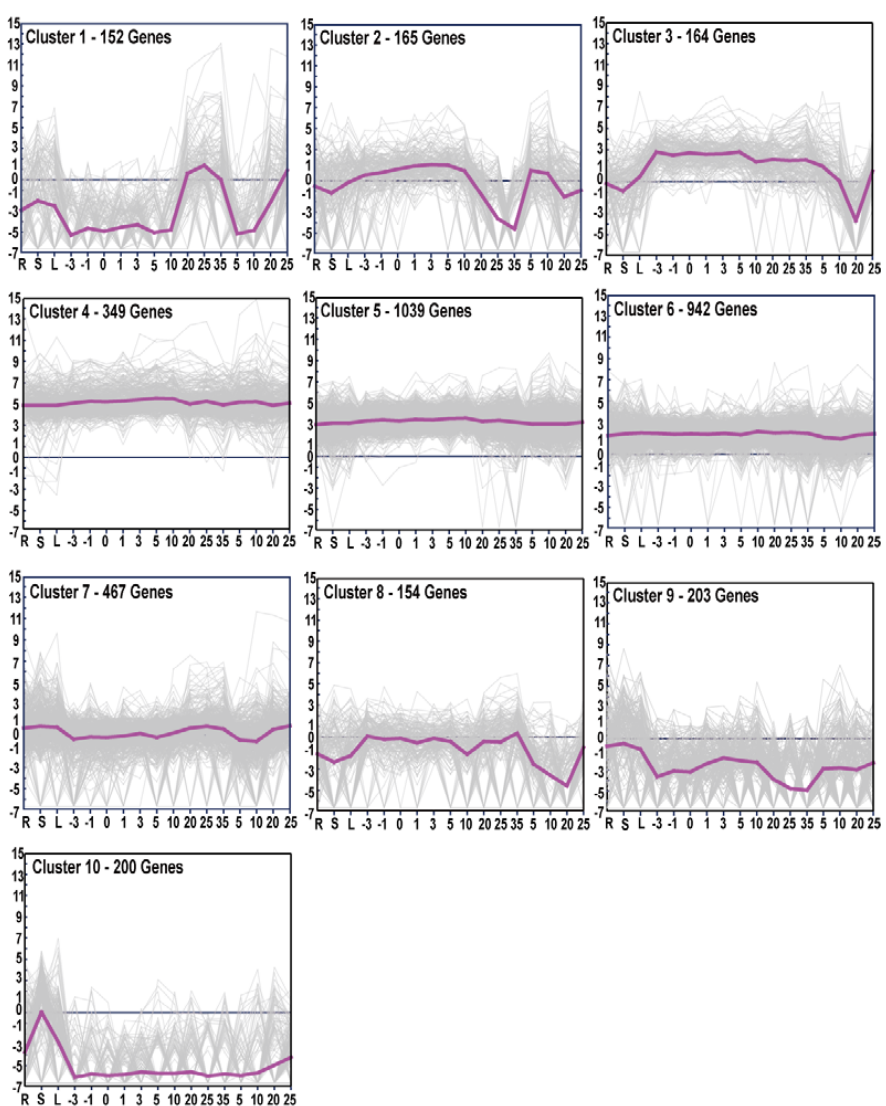
Figure 5. Expression clusters of genes containing polymorphic SNPs or InDels. The cluster analysis was generated by using the K-mean method on the expression profiles of 3835 genes. The ordinate indicated the values of log 2 (FPKM), and the abscissa represented different tissues of cotton, such as root, stem, leaf, − 3–35 DPA of ovule development stages and 5–25 DPA of fiber development